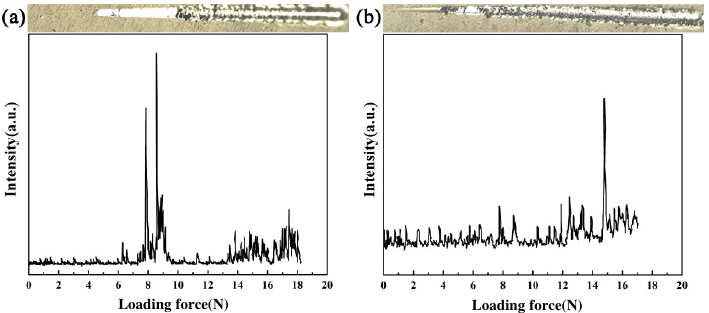
Figure 4. Sound signal and corresponding scratch morphology of diamond film on the GaN substrate with different structure interlayer of ( a ) SiN x (orig) and ( b ) SiN x (peri).